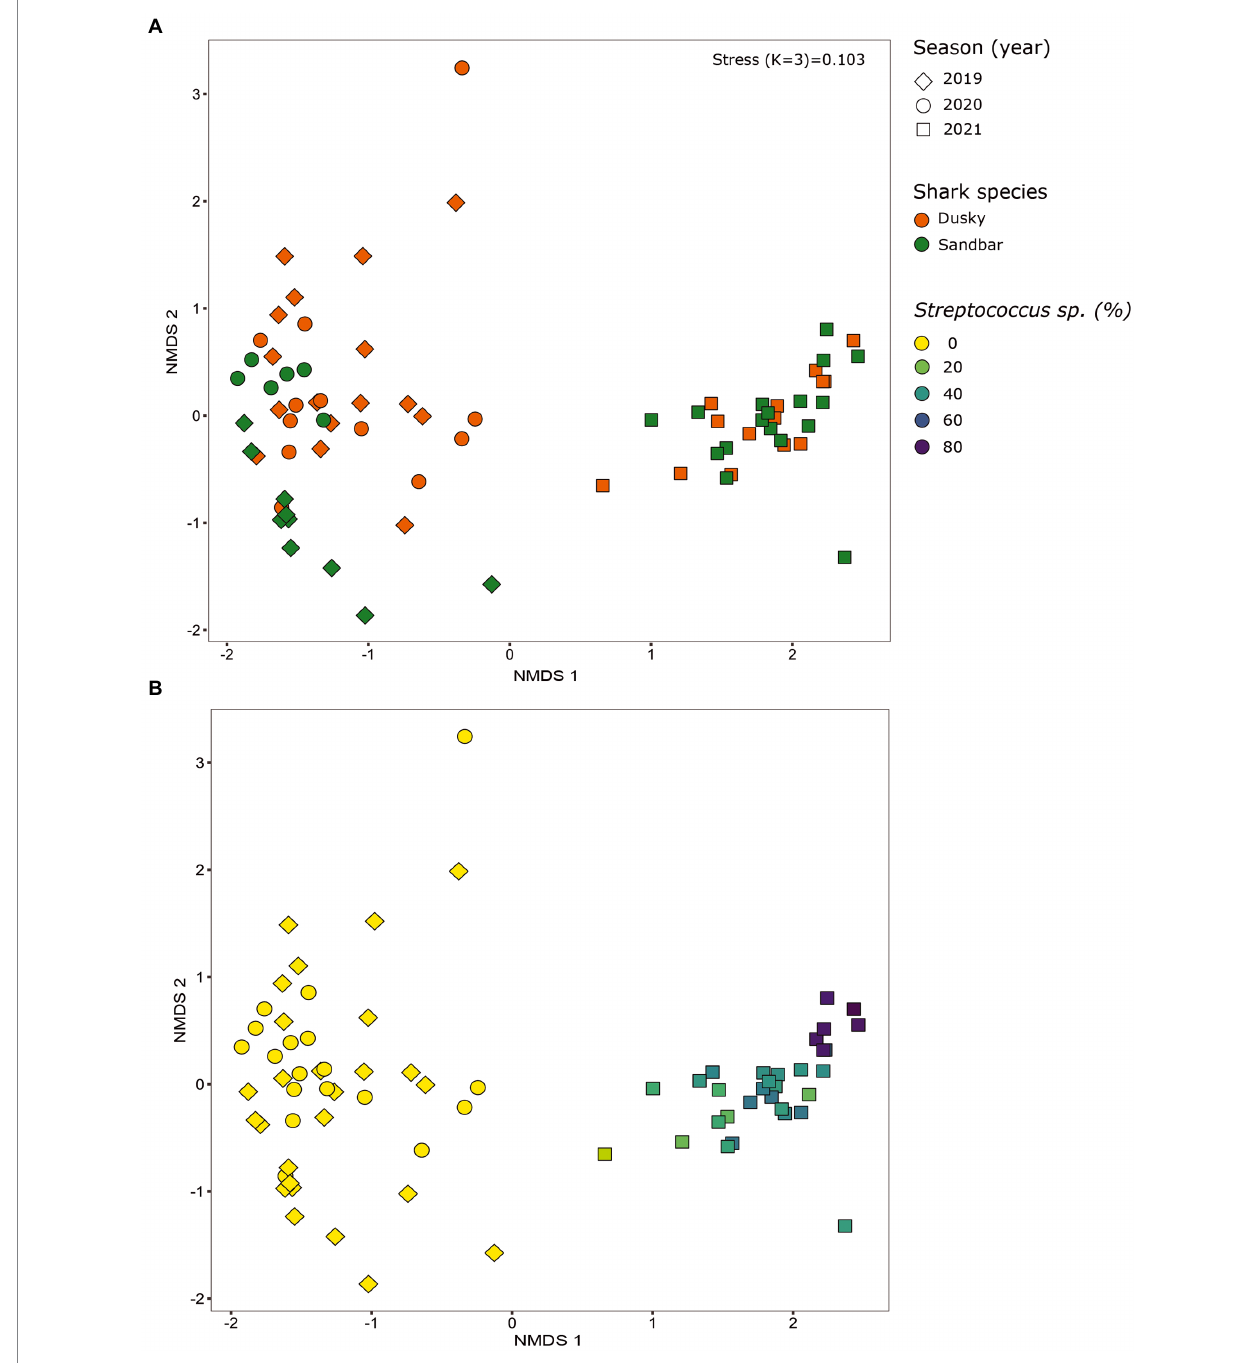
FIGURE 5 Bacterial profiles of sharks across the seasons (years). Non-metric multidimensional scaling analysis was calculated based on Bray-Curtis dissimilarities among samples. The figures show the distribution of the samples by shark species (A) and by the percentage of streptococcus sp. in each sample (B)